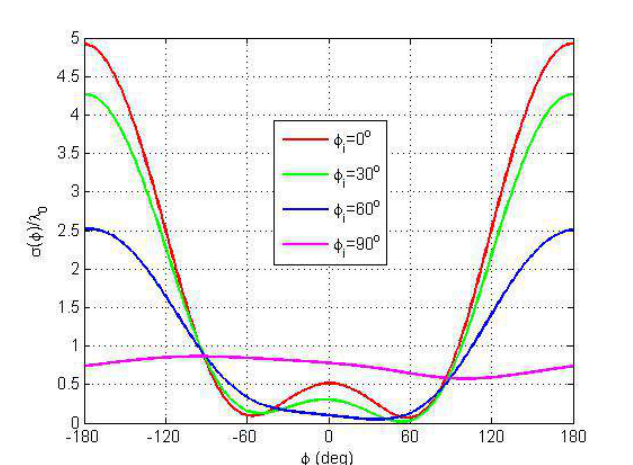
Figure 3: Normalized bistatic width versus scattering angle, when an elliptic ferrite cylinder of axial ratio 2, 𝑘 𝑎 = 1 , as ! well as 𝜇 and 𝜀 is excited by a !! = 7 /9 , 𝜇 !! = −𝑗 5 / 18 , !! = 10, TM polarized plane wave, for 4 distinct angles of incidence. Table I: Echo width per wavelength of the elliptic ferrite cylinder of Fig. 3, whose relative tensor permeability is 𝜇 ! ! (columns 5 – 6), for (columns 2 – 3) or its transpose 𝜇 !